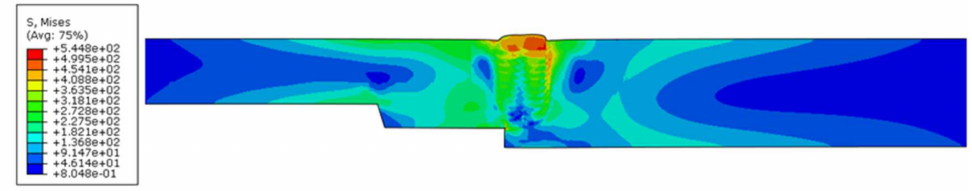
Figure 8. FE prediction of von Mises stress (MPa) distribution in the DMW joint after girth welding.